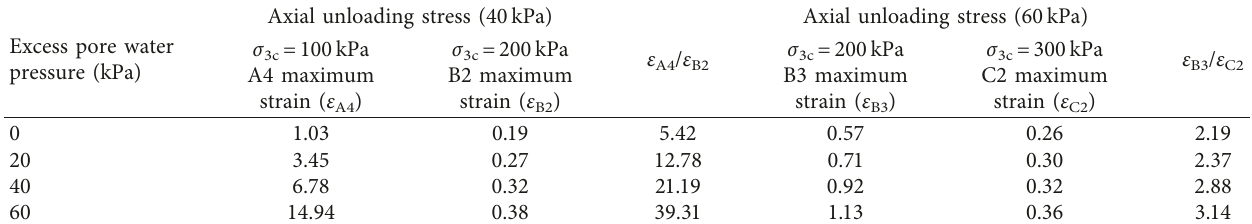
Table 4: The comparison of axial strain at different confining pressures under the same axial unloading stress. Excess pore water pressure